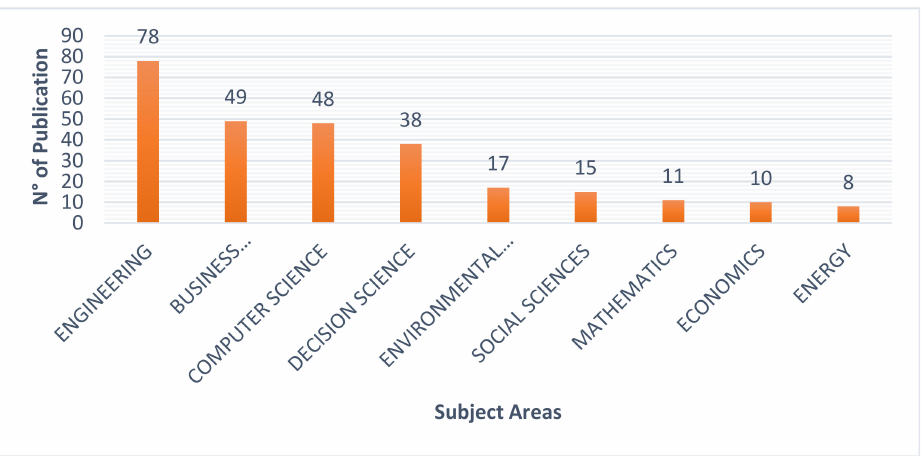
Figure 5. The main breakdown of subject areas.